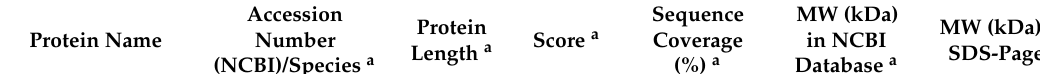
Table 1. List of identified proteins from giant grouper roe and their characteristics.